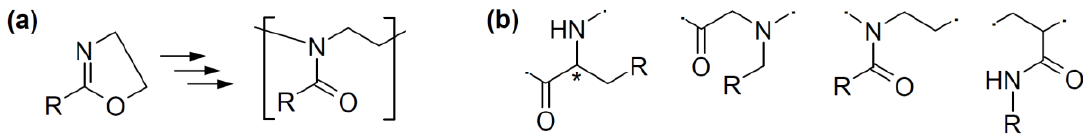
Scheme 1. ( a ) Simplified representation of the cationic ring-opening polymerization of 2-substituted-2-oxazolines. ( b ) Isomeric structures of amide repeating units, from left to right: amino acid, N -alkyl glycine, N -acyl ethyleneimine (poly(2-oxazoline)), and N -alkyl acrylamine